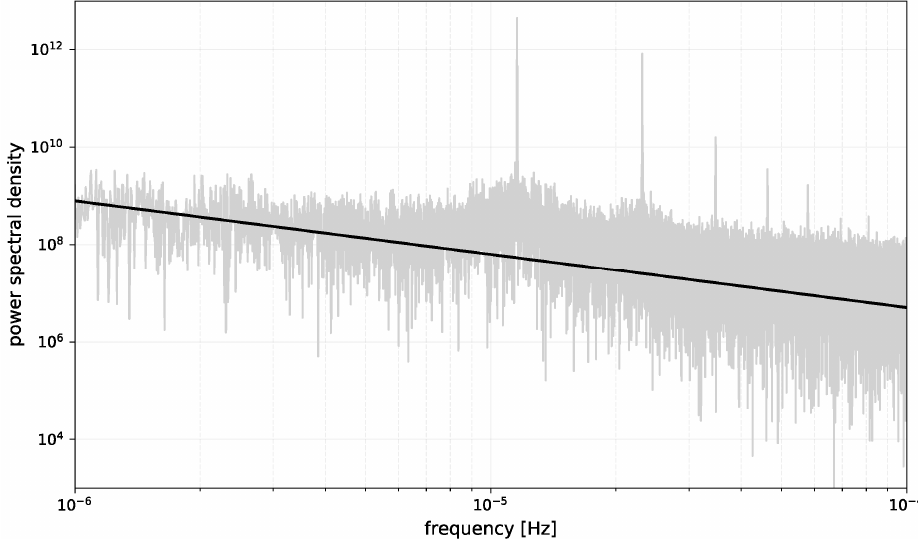
Figure 2. Power spectral density of the hourly solar irradiance (grey) and trend 1 / f α characterized by α = 1.1 (black).